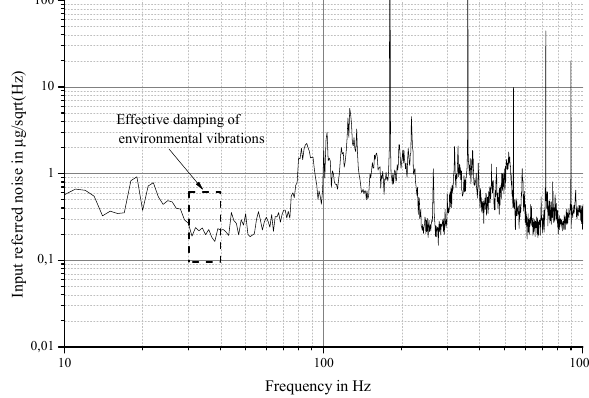
Figure 12. Measurement results of the input referred accelerometer noise.